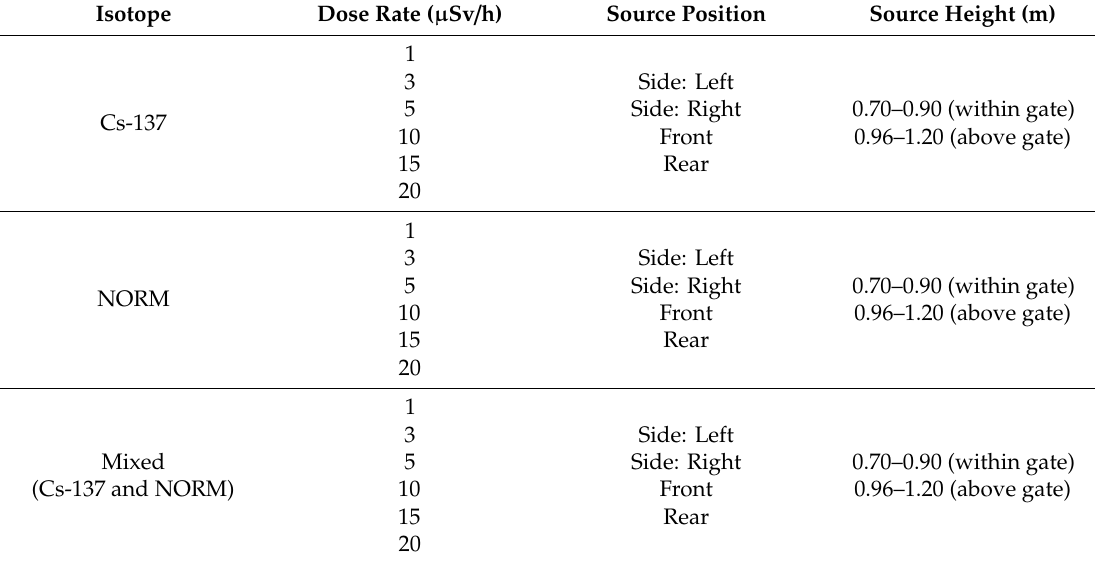
Table 3. Summary of the Project Gatekeeper system validation parameters. (N.B. the isotopes of each dose-rate (activity) were used in each of the four stated source positions and